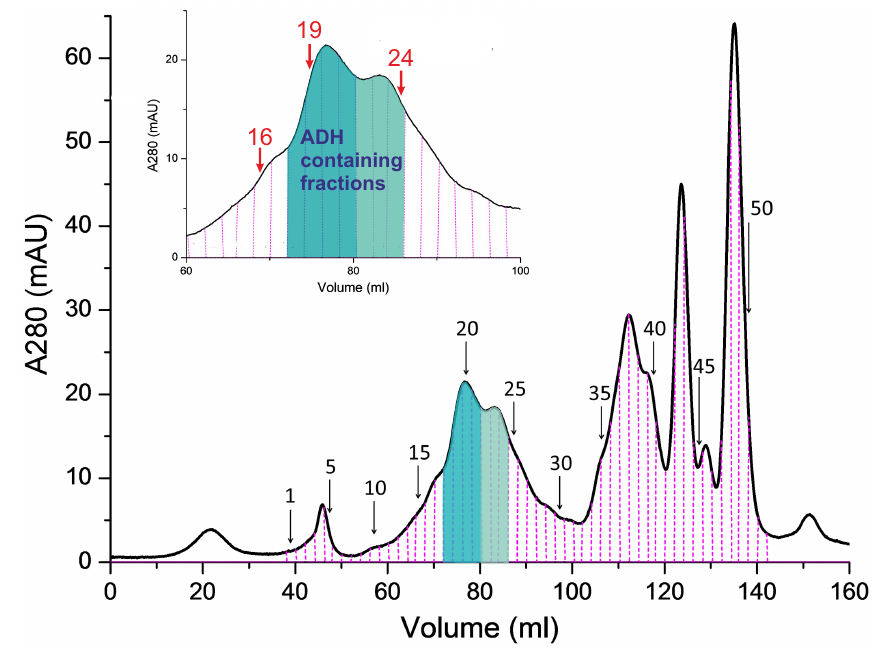
Figure 3. Chromatogram of the ADH reagent. The fractions with molecular weight close to ADH dimer are shown in the inset in an expanded scale. The fractions 18–21 that exhibited fluorescence under excitation at 720 nm and 840 nm are colored with dark green. The fractions 22–24 that exhibited fluorescence only under excitation at 720 nm, but not 840 nm are colored with light green.